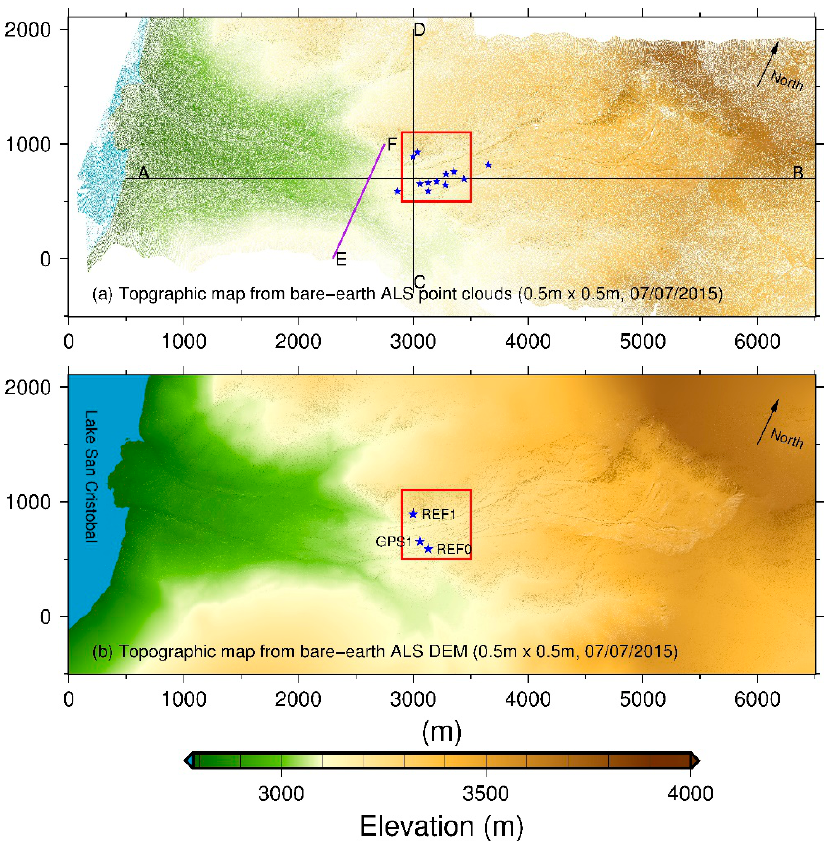
Figure 3. ( a ) A topographic map depicting bare-earth ALS point clouds collected on 7 July 2015. The ALS points have been down-sampled to 0.5-m by 0.5-m grids. Stars indicate Global Navigation Satellite Systems (GNSS) stations that were installed for georeferencing Terrestrial Laser Scanning (TLS) points. ( b ) A shaded relief map from a bare-earth DEM derived from the ALS points shown in ( a ). The red square shows the area that was also scanned by TLS on 7 July 2015.